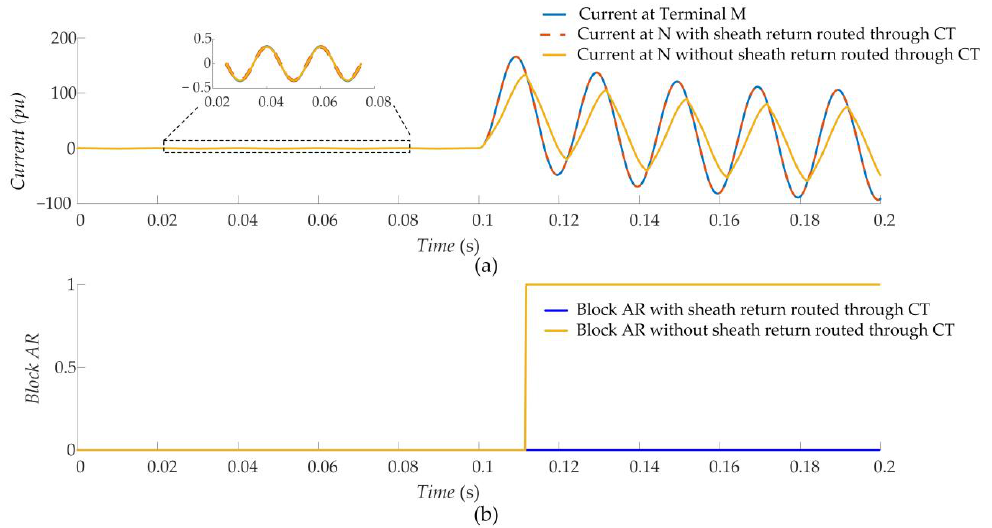
Figure 5. Performance of the proposed scheme with SVL conduction for an external fault and different CT arrangements, ( a ) UGC terminal currents, ( b ) selective AR performance.